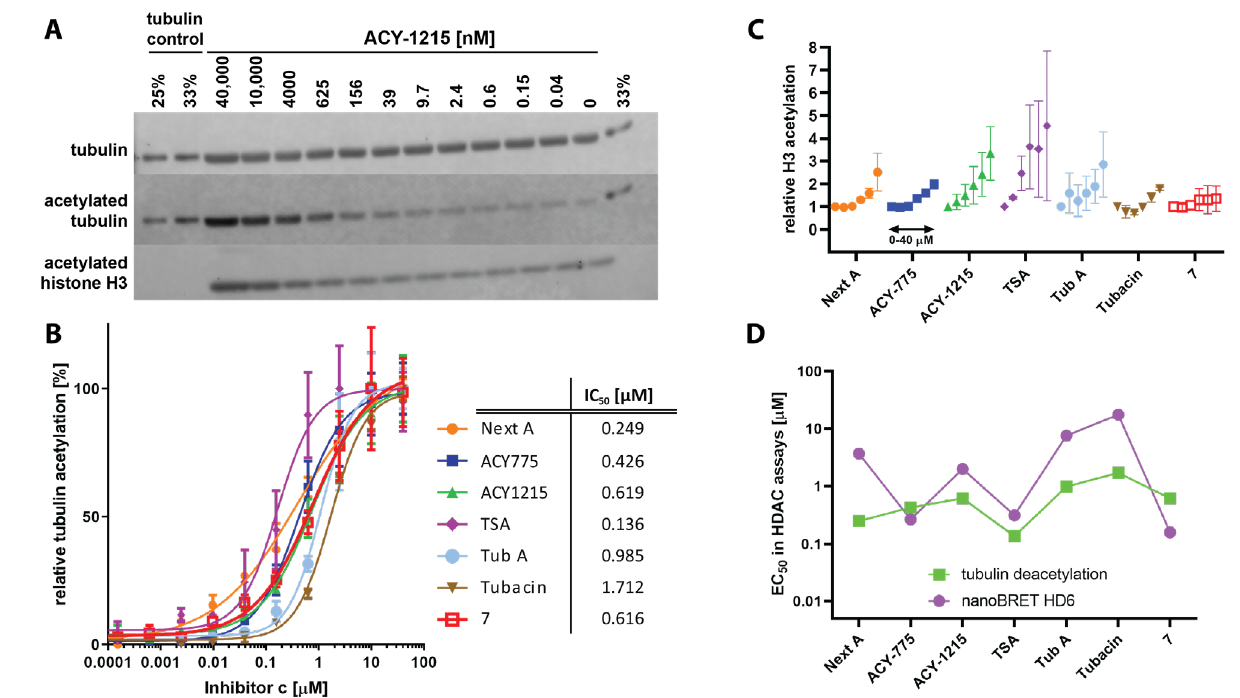
Figure 3. Tubulin/histone deacetylation inhibition assay. Panel ( A ) RPMI-8226 cells were treated with dilution series of HDAC6is for six hours and levels of Ac-tubulin and Ac-H3 were determined by Western blotting (ACY-1215 shown as a representative). Panel ( B ) Acetylation values were normalized to total tubulin and plotted as relative tubulin acetylation. IC 50 values were calculated from fitted curves. The potency of tested compounds to inhibit tubulin deacetylation ranges from 136 nM to 1.7 µM for TSA and Tubacin, respectively. Panel ( C ) Quantification of the effect of inhibitors on the acetylation status of histone H3. Panel ( D ) Comparison of EC 50 values for tubulin deacetylation and nanoBRET HDAC6 assays.